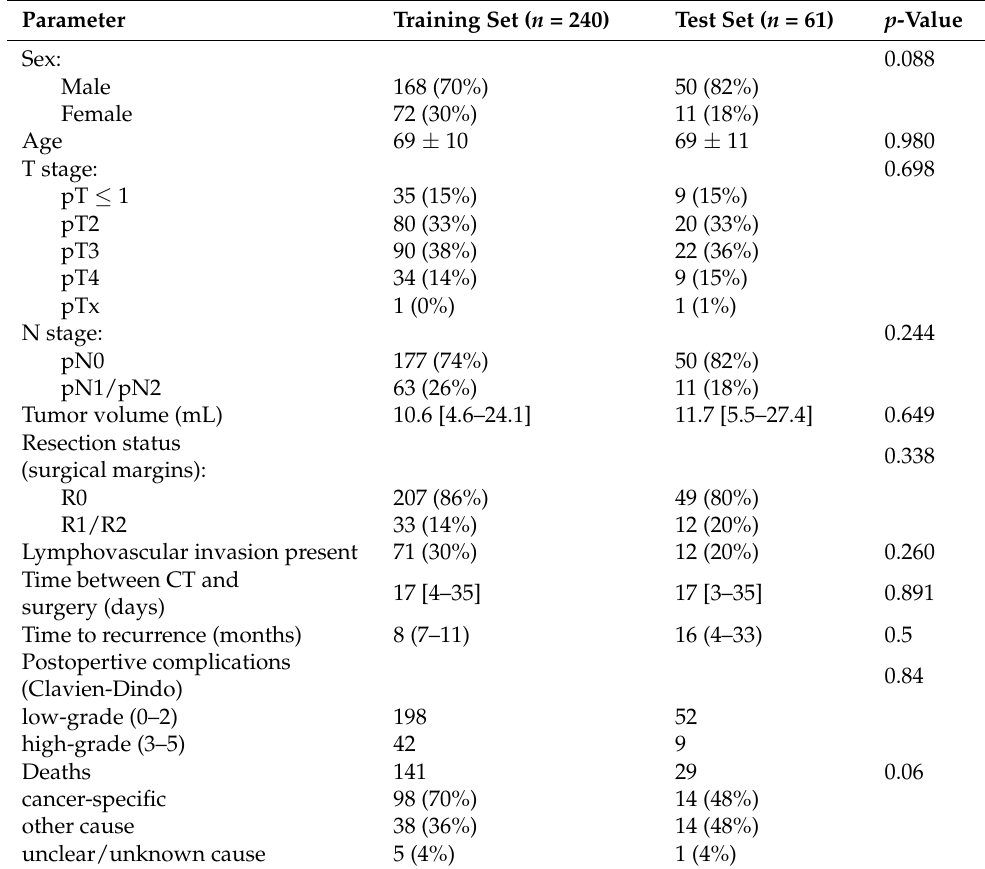
Table 1. Clinical characteristics of the study cohort.